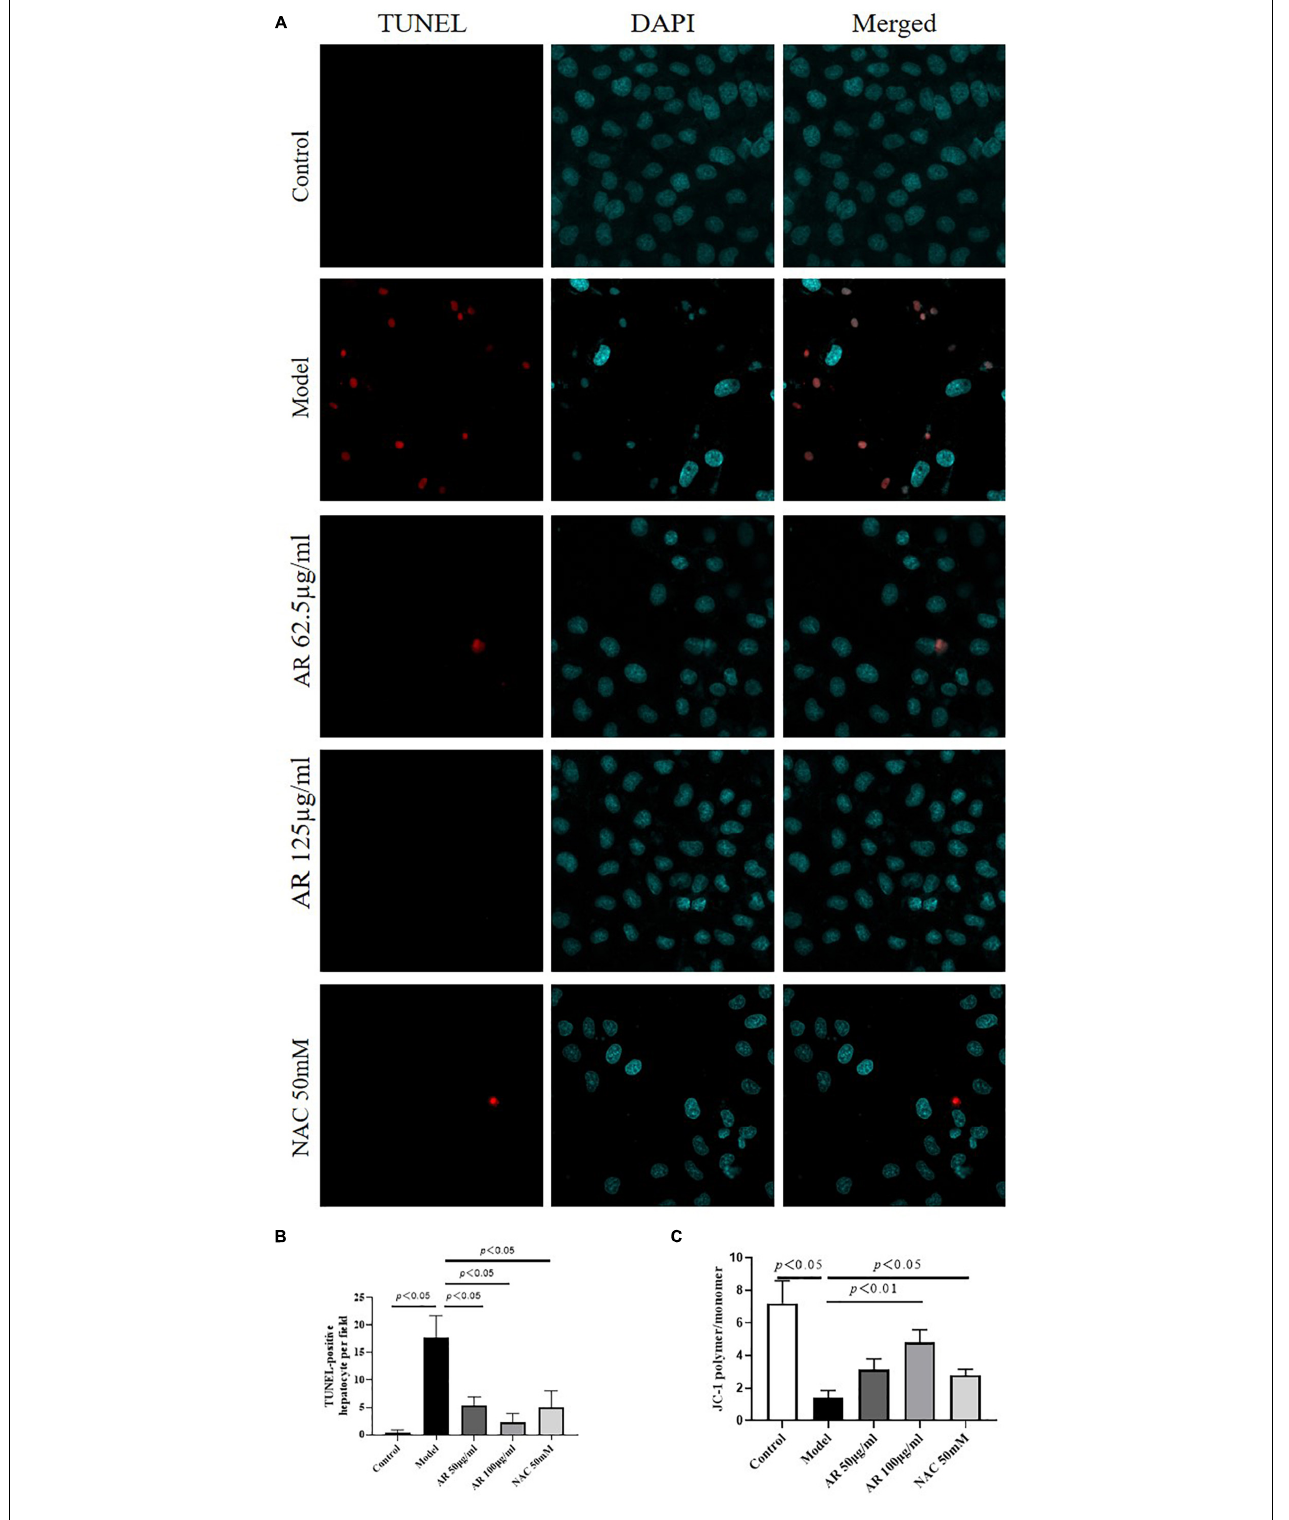
FIGURE 9 | Protective effects of Astragali Radix (AR) on APAP induced hepatocyte injury in L-02 cells. (A) The typical images of TUNEL staining (original magnification, 600 × ; blue: 4’,6-diamidino-2-phenylindole (DAPI); red: TUNEL). (B) TUNEL-positive hepatocyte of ten high-power fields at × 600 magnification in each field. (C) Semi quantification data for expression of MMP in L-02 cells by examining the fluorescence intensity ratio of JC-1 aggregation/JC-1 monomer.